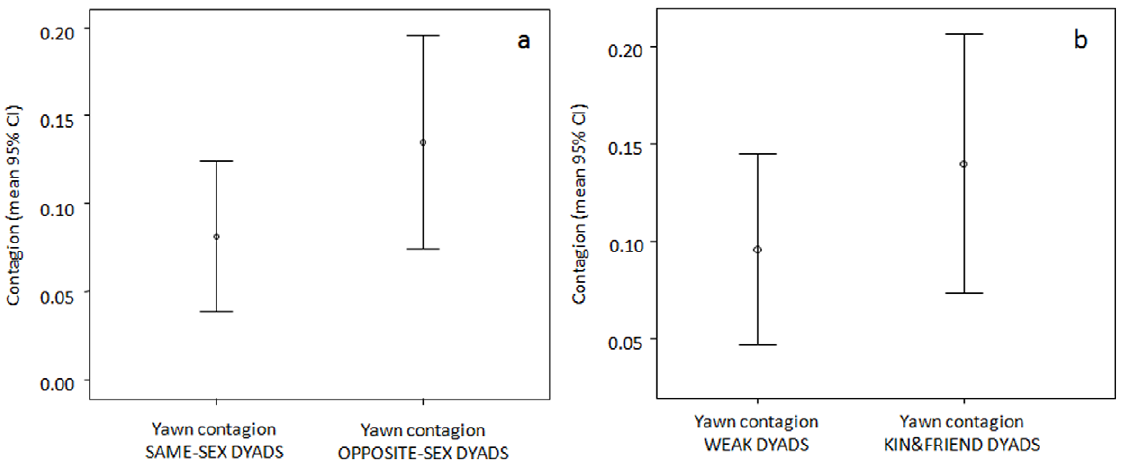
Figure 4. Frequency of yawn contagion as a function of the sex of the subjects involved (a) and of the relationship quality of the dyads involved (b).